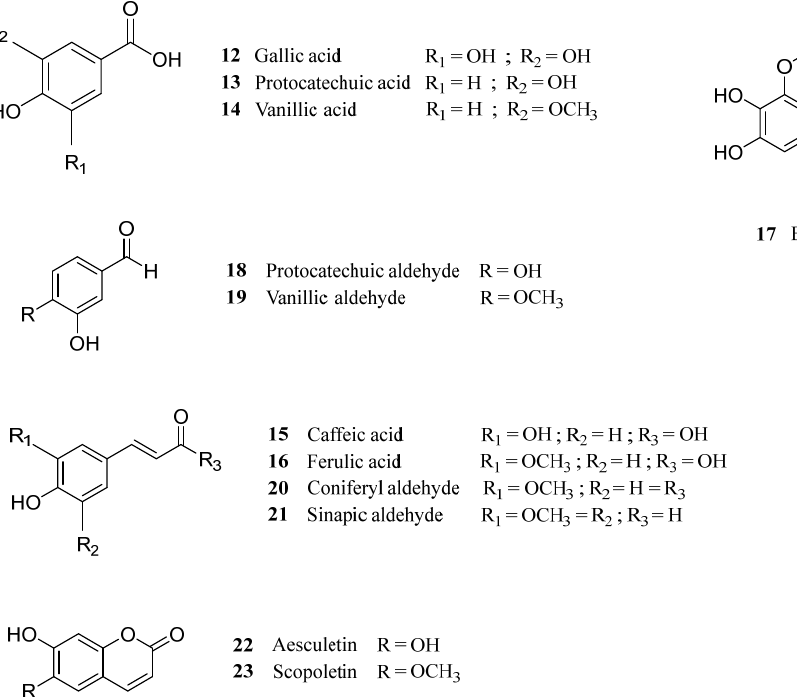
Figure 4. Chemical structure of the main phenolic acids, aldehydes and coumarins identified in the “extractive” fraction of cork.